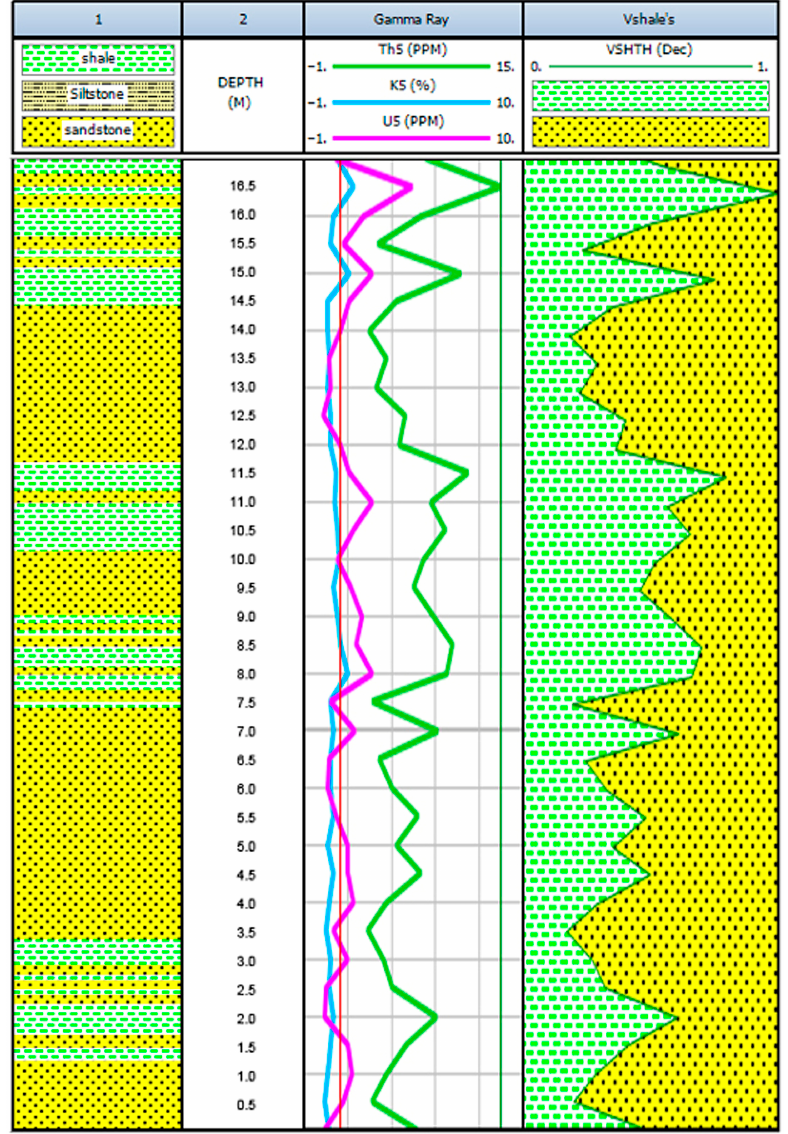
Figure 9. The sedimentary log of the L5 outcrop, including lithology thicknesses, texture, SGR values, and shale volume.